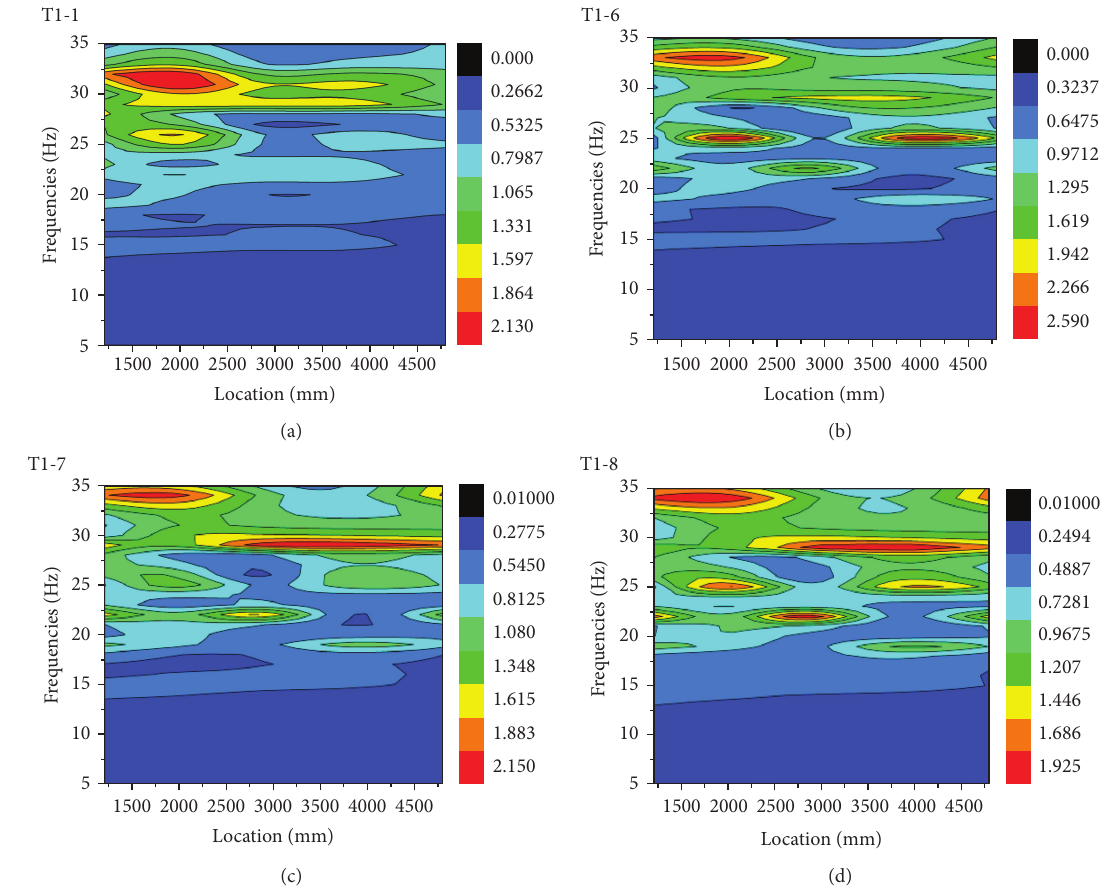
Figure 13: Transfer functions of the T1 test floors with the 400mm joist spacing.